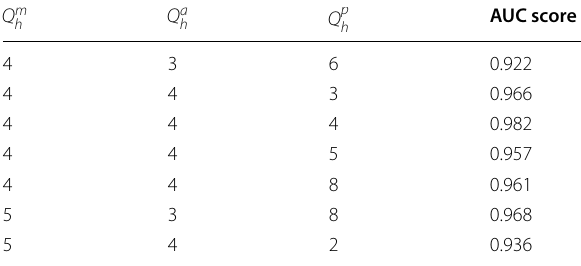
Table 13 AUC scores of THV (or T of Hessian magnitude, Hessian azimuth and Hessian polar angle using leave-one out cross